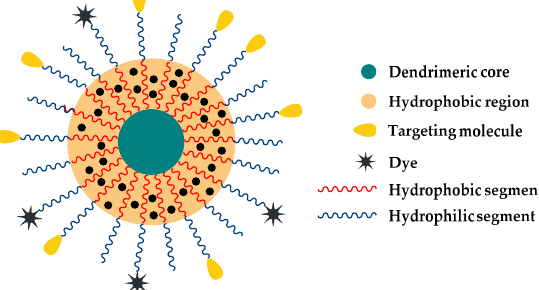
Figure 3. Schematic representation of the unimolecular micelle formed by multi-arm star amphiphilic block copolymer PAMAM-PVL-PEG-OCH 3 /Cy5/KE108. Reproduced with permission from reference [28], Elsevier, 2016 .